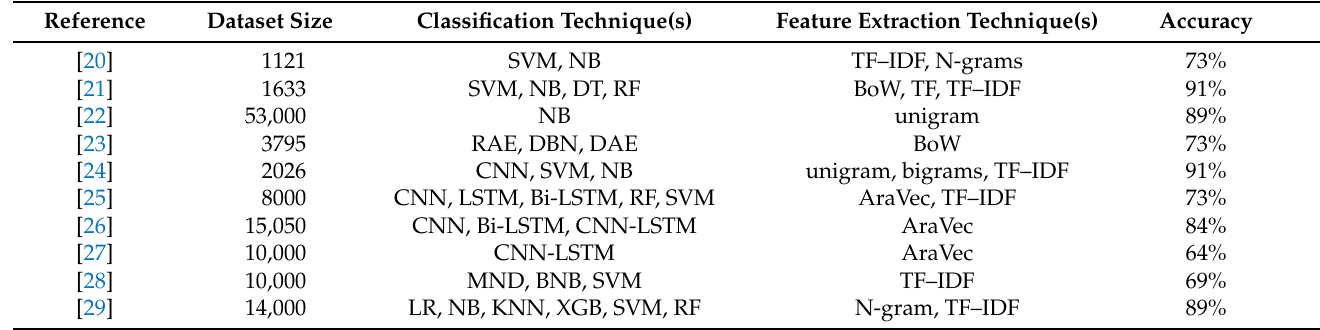
Table 1. Summary of the most recent research about corpus/machine learning